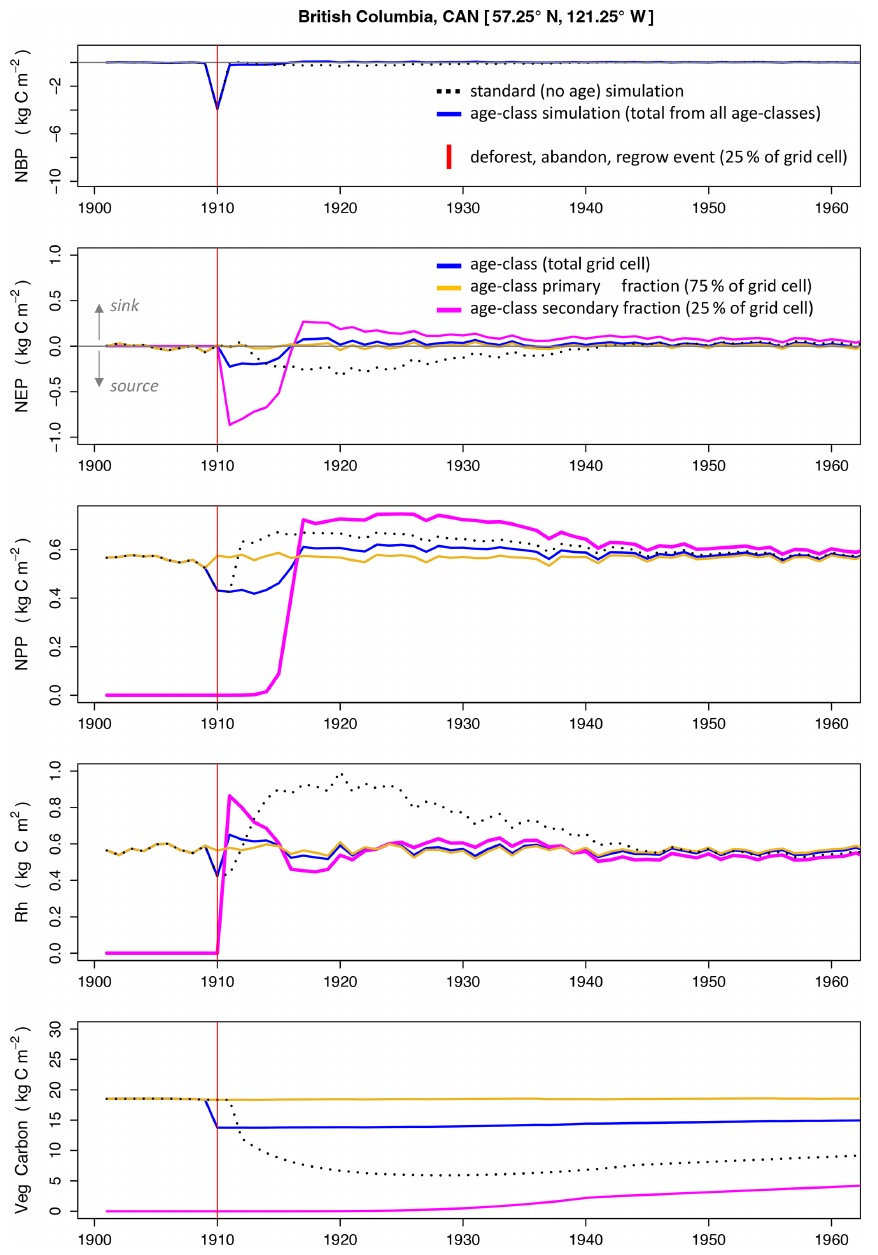
Figure 5. A time-series comparison between the standard LPJ-wsl v2.0 simulation ( S noage_event ) and the age-class approach ( S age_event ) in an idealized single-cell simulation of a deforestation, abandonment, and subsequent regrow event. The x axis is the simulation year. See Table 2 for simulation